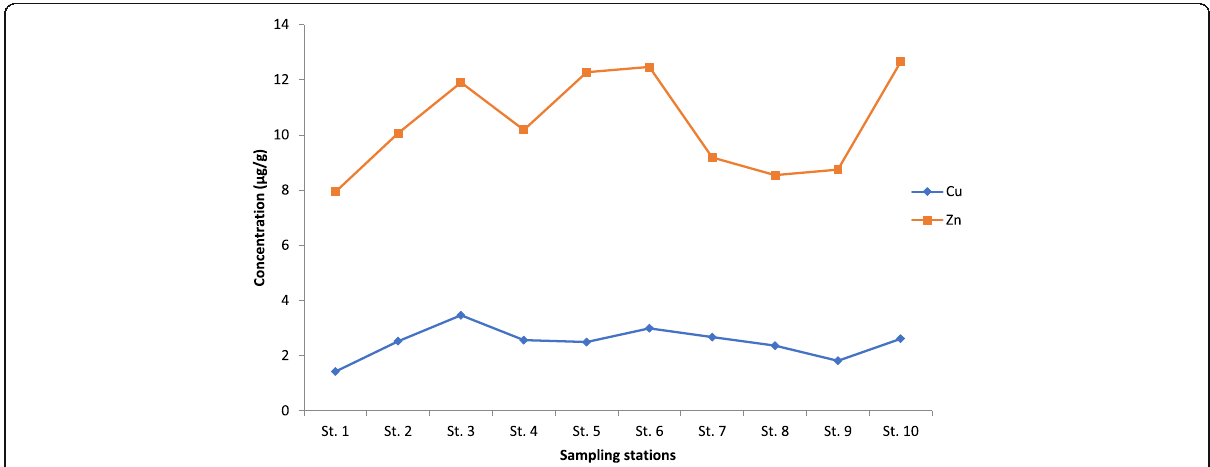
Fig. 4 Concentrations of Cu and Zn in L. varicus of River Osun, Osogbo, Nigeria (June 2015 – March